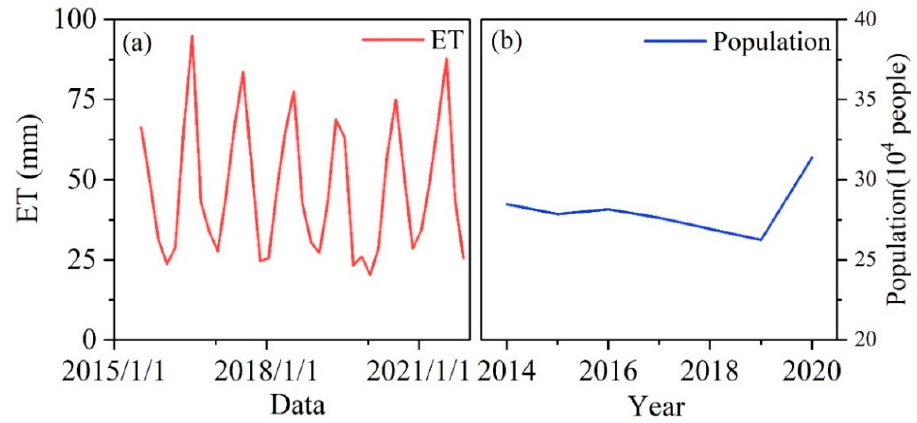
Figure 4. The potential monthly ET ( a ); the yearly population of the Beihu catchment (B).